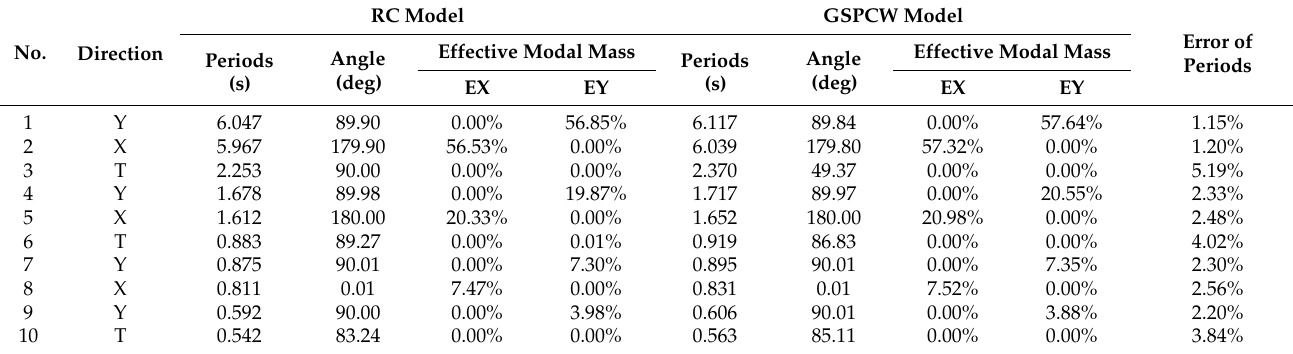
Table 6. Comparison of the dynamic characteristics between the RC and GSPCW building models.